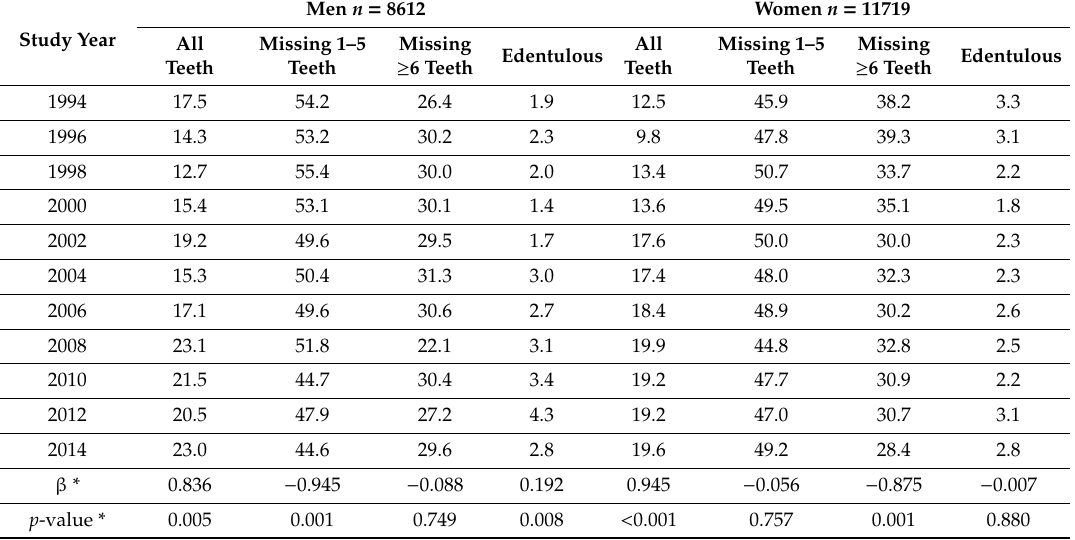
Table 3. Distribution (%) of men and women by a number of teeth in